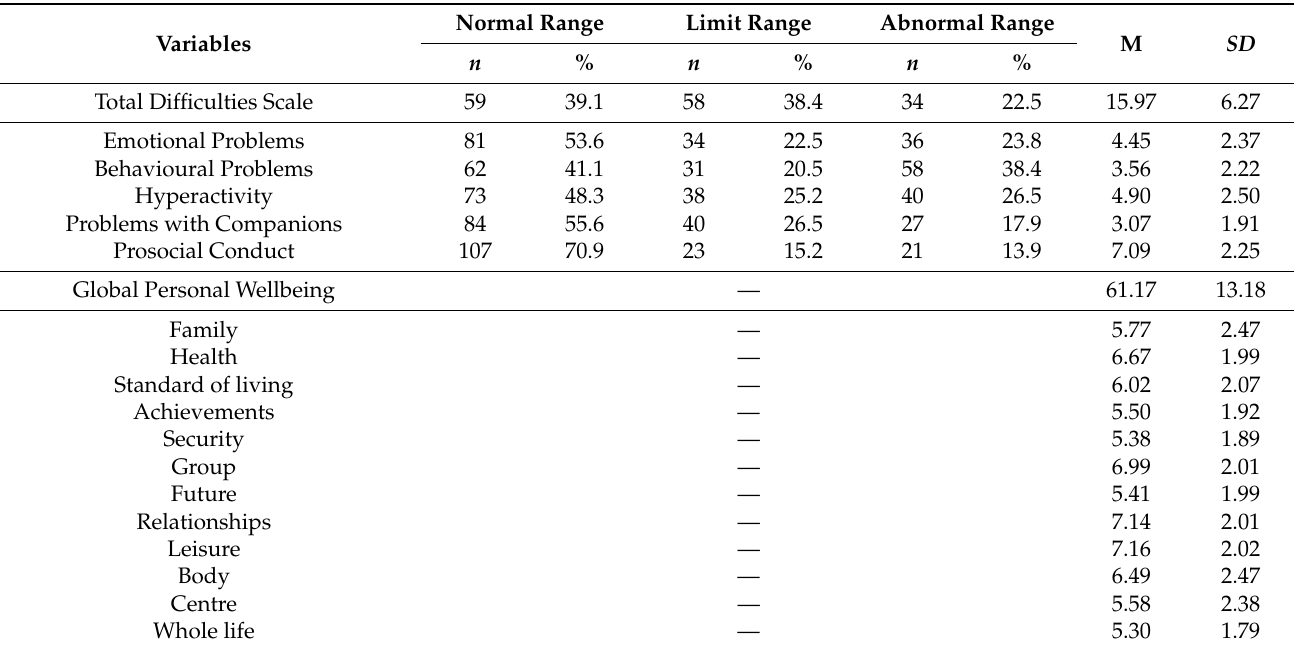
Table 1. Descriptive statistics of the emotional and behavioural difficulties and of the adolescents’ personal